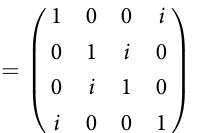
be 0.9986, 0.9967, 0.9974, 0.9975, 0.9977, and 0.9989 (all with average uncertainty of ± 0.0010), for the gates depicted in Fig. 6a through Fig. 6f, respectively.